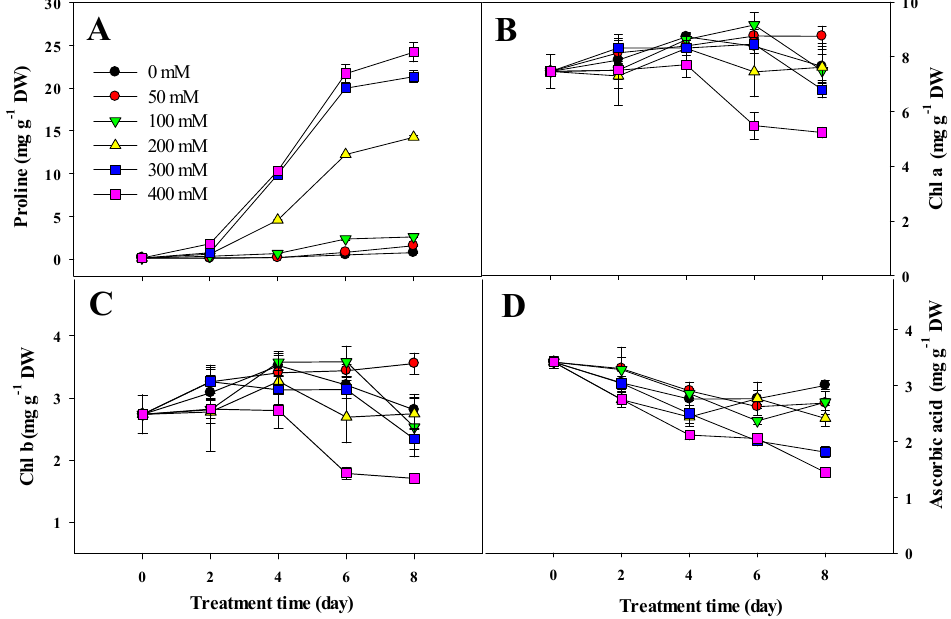
Figure 3. Effect of NaCl concentration on proline ( A ), chl a ( B ), chl b ( C ), and ascorbic acid content ( D ) of lettuce seedlings during the progressive treatment schedule. Each plot point represents mean ± SD of three replicates.